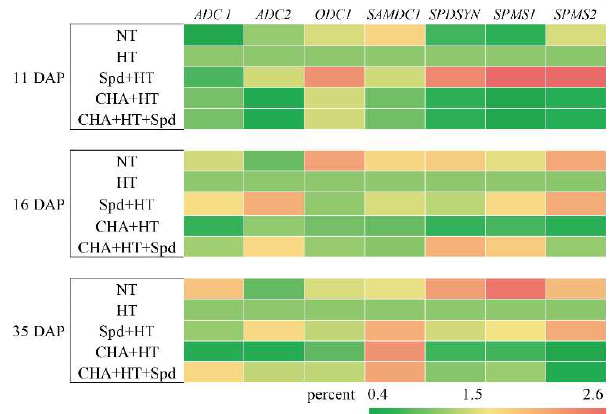
Figure 6. Effects of exogenous Spd and CHA on polyamine synthesis-related gene expressions of rice seeds during development under high temperature (40 °C, 5 days). The expression level of HT was regarded as 1.0. The treatment methods were the same as those in the Figure 1 notes.